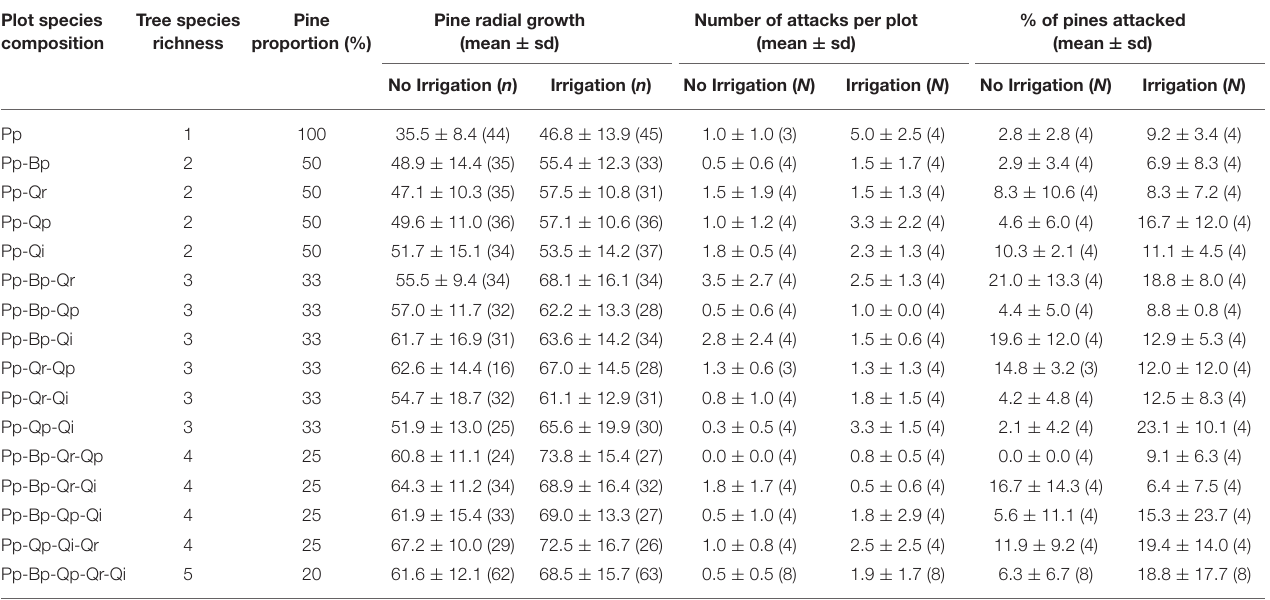
% of pines attacked (mean ± sd)